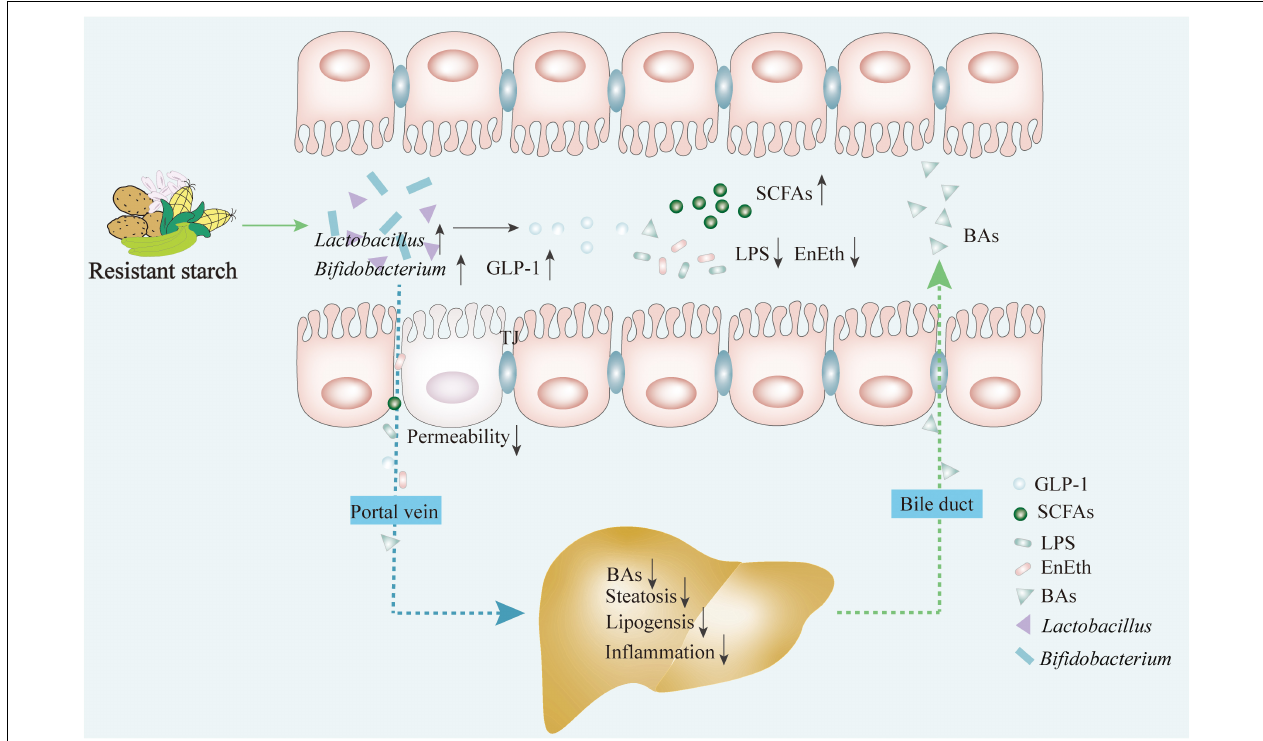
FIGURE 2 | RSs exert the effects on ameliorating NAFLD via restoring the gut microbiota structure and regulating bacterial metabolites through the link between gut and liver. Intake of RSs contributes to: (1) improving the growth of probiotics (e.g., Lactobacillus and Bifidobacterium ); (2) promoting the production of metabolites (e.g., short chain fatty acids and glucagon-like peptide-1); (3) inhibiting harmful metabolites production (e.g., LPS and EnEth); and (4) maintaining the homeostasis of the BAs. This regulates the enterohepatic axis homeostasis by modulating flora metabolite and intestinal hormone productions to inhibit hepatic steatosis, lipogenesis, and inflammatory responses. BAs, bile acids; EnEth, endogenous ethanol; GLP-1, glucagon-like peptide-1; LPS, lipopolysaccharide; RS, resistant starch; SCFAs, short-chain fatty